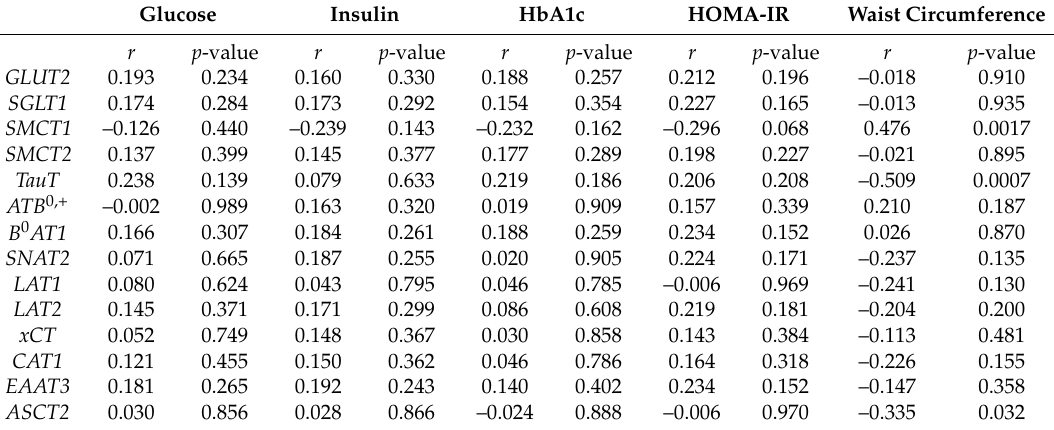
Table 3. Correlation between jejunal mRNA abundance of the nutrient transporters (NTs) glucose, insulin, HbA1c, HOMA-IR, and Waist Circumference. The mRNA abundance for the NTs are expressed as 40- ∆ C T values